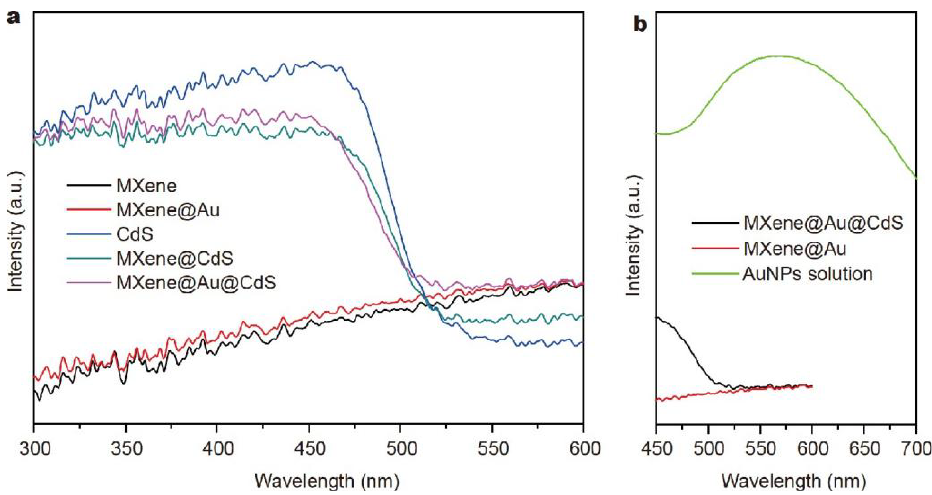
Figure 10. UV–Vis DRS spectra of MXene, MXene@Au, MXene@CdS and MXene@Au@CdS ( a ); enlarged curves of MXene@Au, MXene@Au@CdS and AuNPs solution ( b ) [67]. enlarged curves of MXene@Au, MXene@Au@CdS and AuNPs solution ( b )